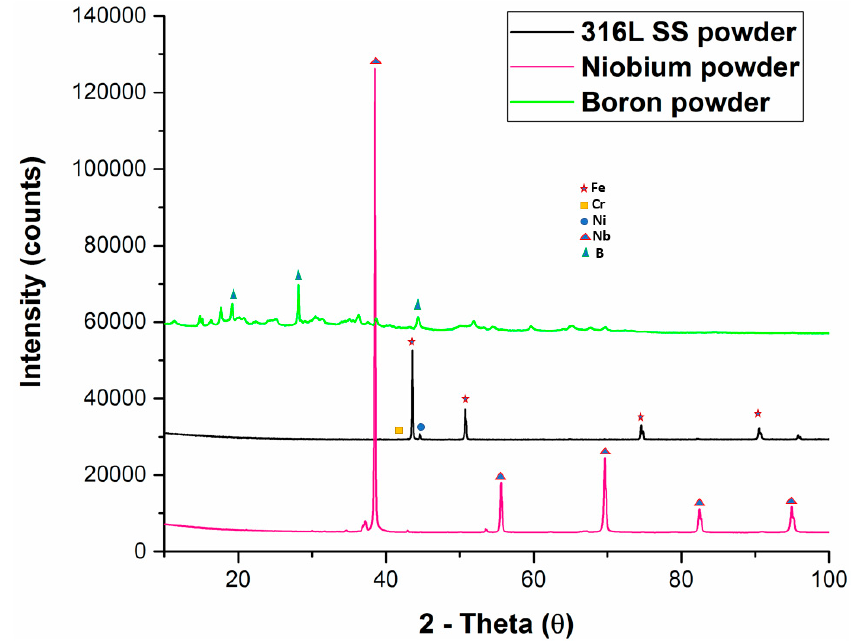
Figure 2. XRD spectra of niobium, boron and 316L SS powder.